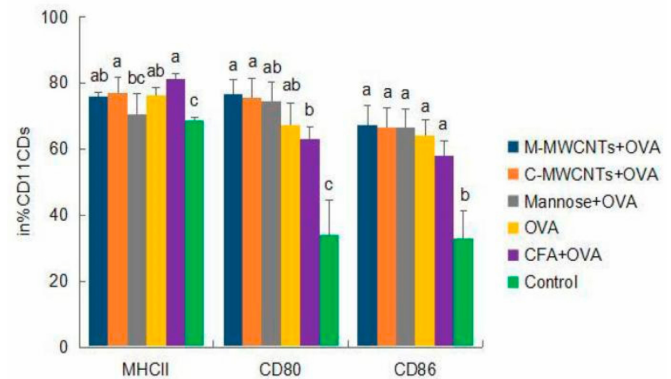
Figure 7. Effects of M-MWCNT on the maturation of DCs in ICR mice. The splenocytes suspension were prepared from the spleens of ICR mice 48 h after the first immunization. Point diagram analysis of dendritic cell double-stained with CD11c + -MHC-II + , CD11c + -CD86 + , and CD11c + -CD80 + . The percentage of CD80 + , MHC II + , and CD86 + cells against total DCs was determined by using flow cytometry. Distribution map of CD11c + -MHCII + , CD11c + -CD86 + , and CD11c + -CD80 + co-expressing cells in Supplementary Materials. The data are presented as the mean ± SD ( n = 3) analyzed by one-way ANOVA and then Duncan’s multiple-range tests. Different letters (a, b, c, and d) above each group of bars indicate statistically significant differences ( p <